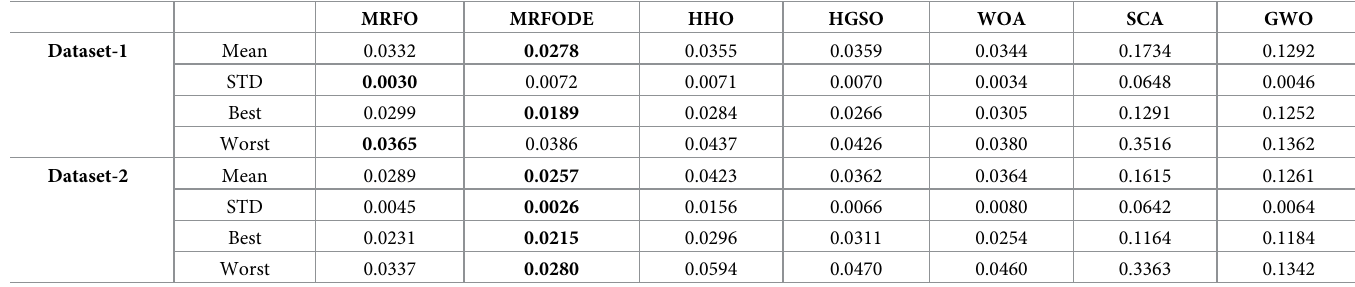
Table 3. Results of fitness value for MRFODE and other methods.